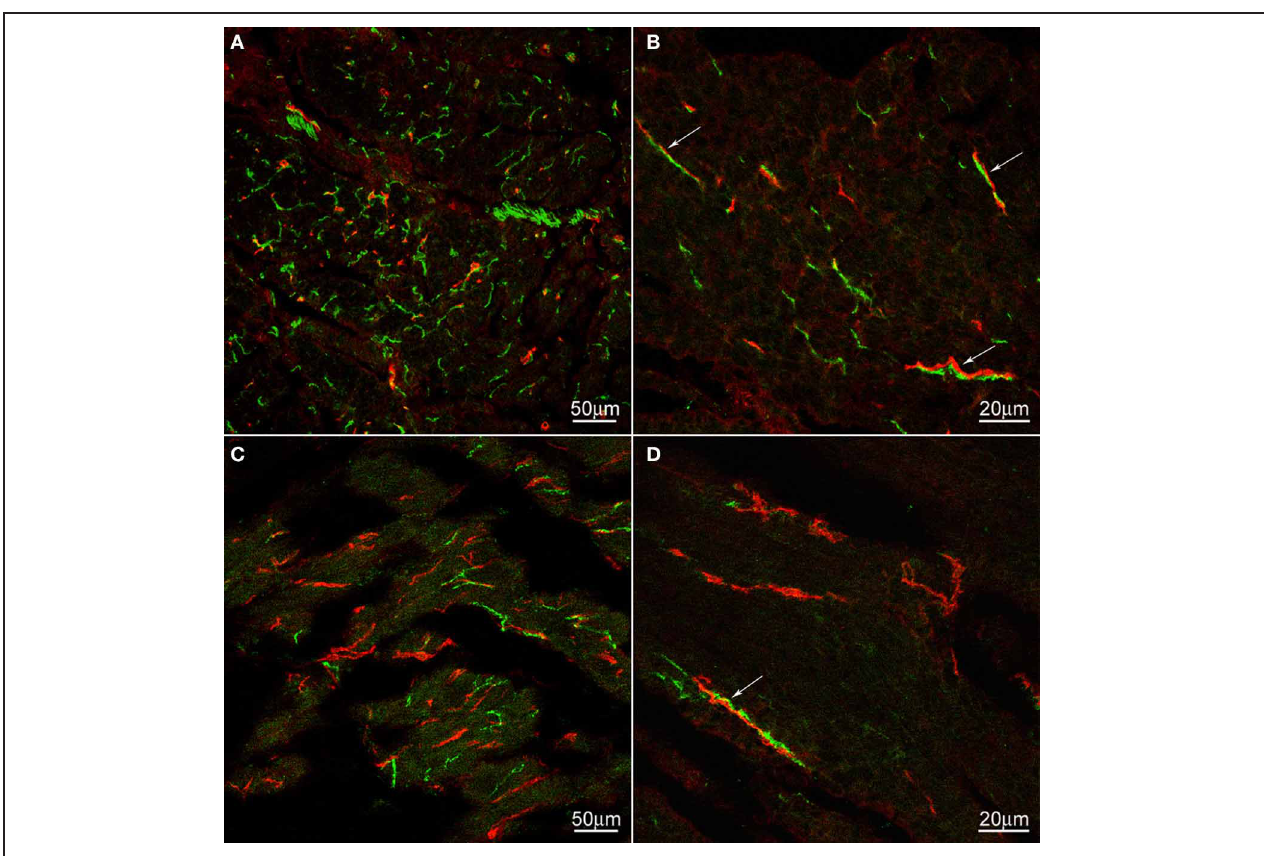
FIGURE 3 | c-Kit (red) and nNOS (green) immunoreactivities in control (A,B) and achalasia patient (archived specimen) (C,D). No density difference was not found in ICC between control and the achalasia patient. nNOS nerve density was markedly decreased in the achalasia patient